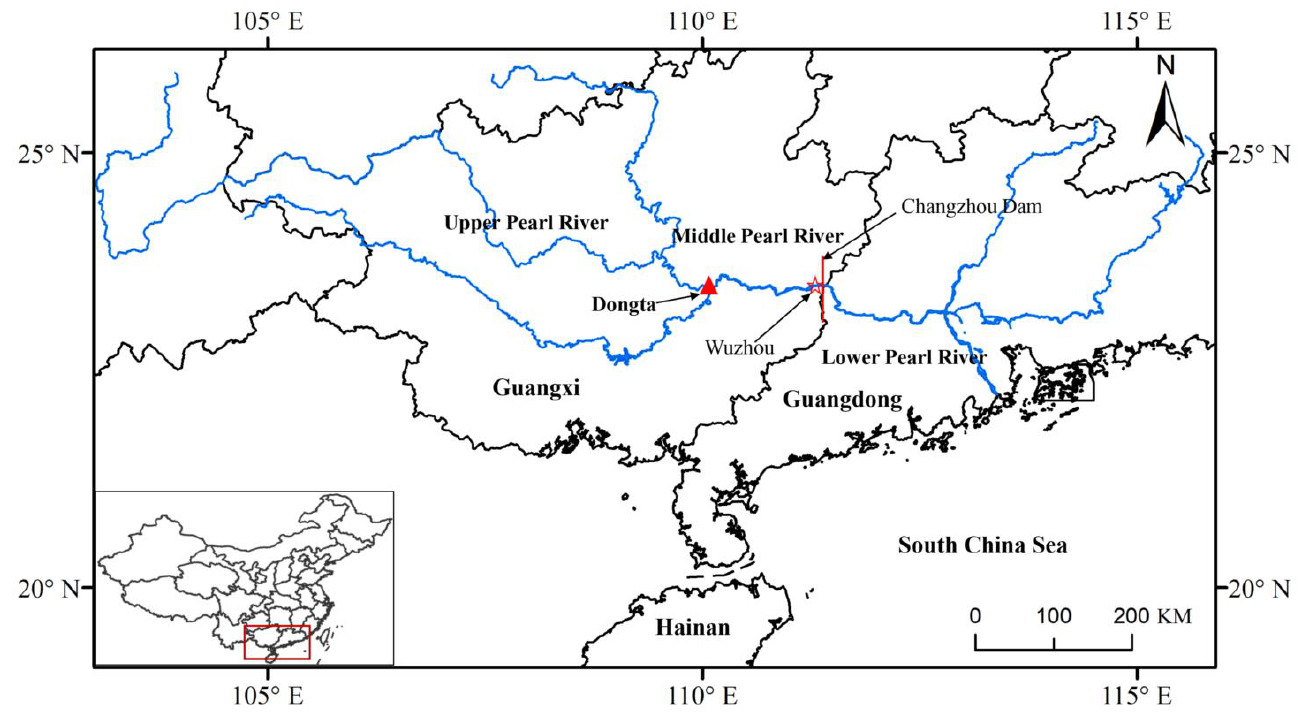
Figure 1. Map of the localities where fish larvae were collected in this study (triangle). Red line indicates the dams constructed in the middle and lower Pearl River.